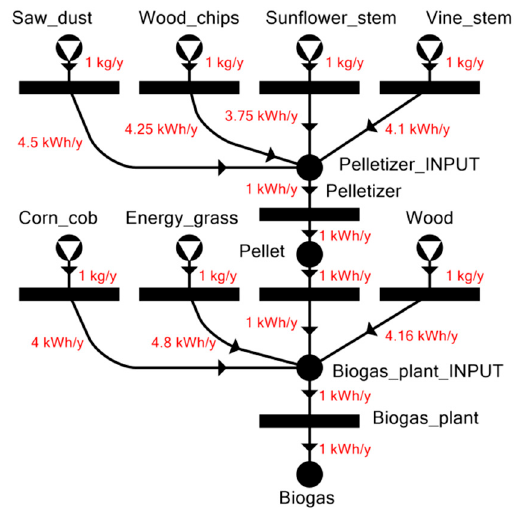
Figure 7. Process network for the production of biogas from the different biomass types. Note that the unnamed operating units are logical operating units representing heating value conversion for each raw material.